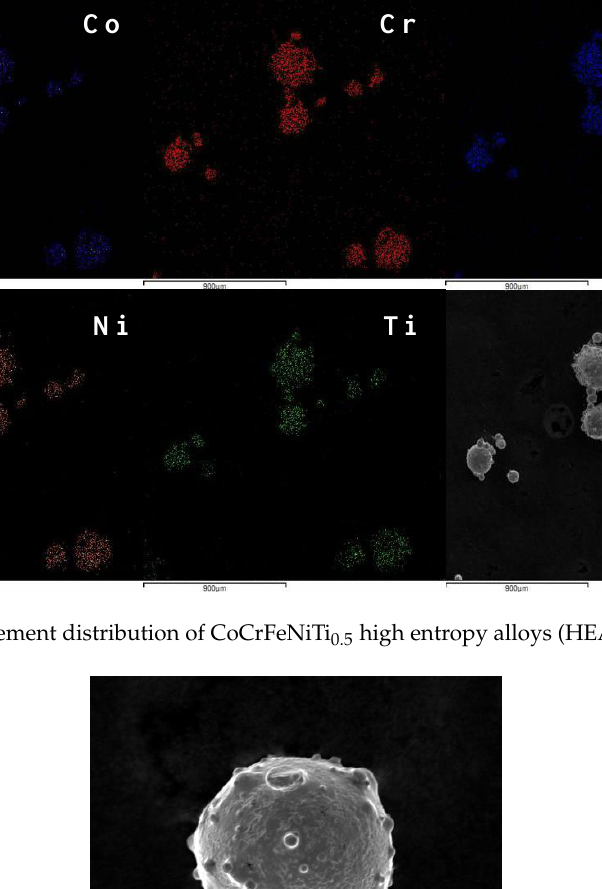
Figure 2. Microstructure of CoCrFeNiTi 0.5 HEA power. Table 1. Element Atomic Ratio of CoCrFeNiTi 0.5 HEA power.